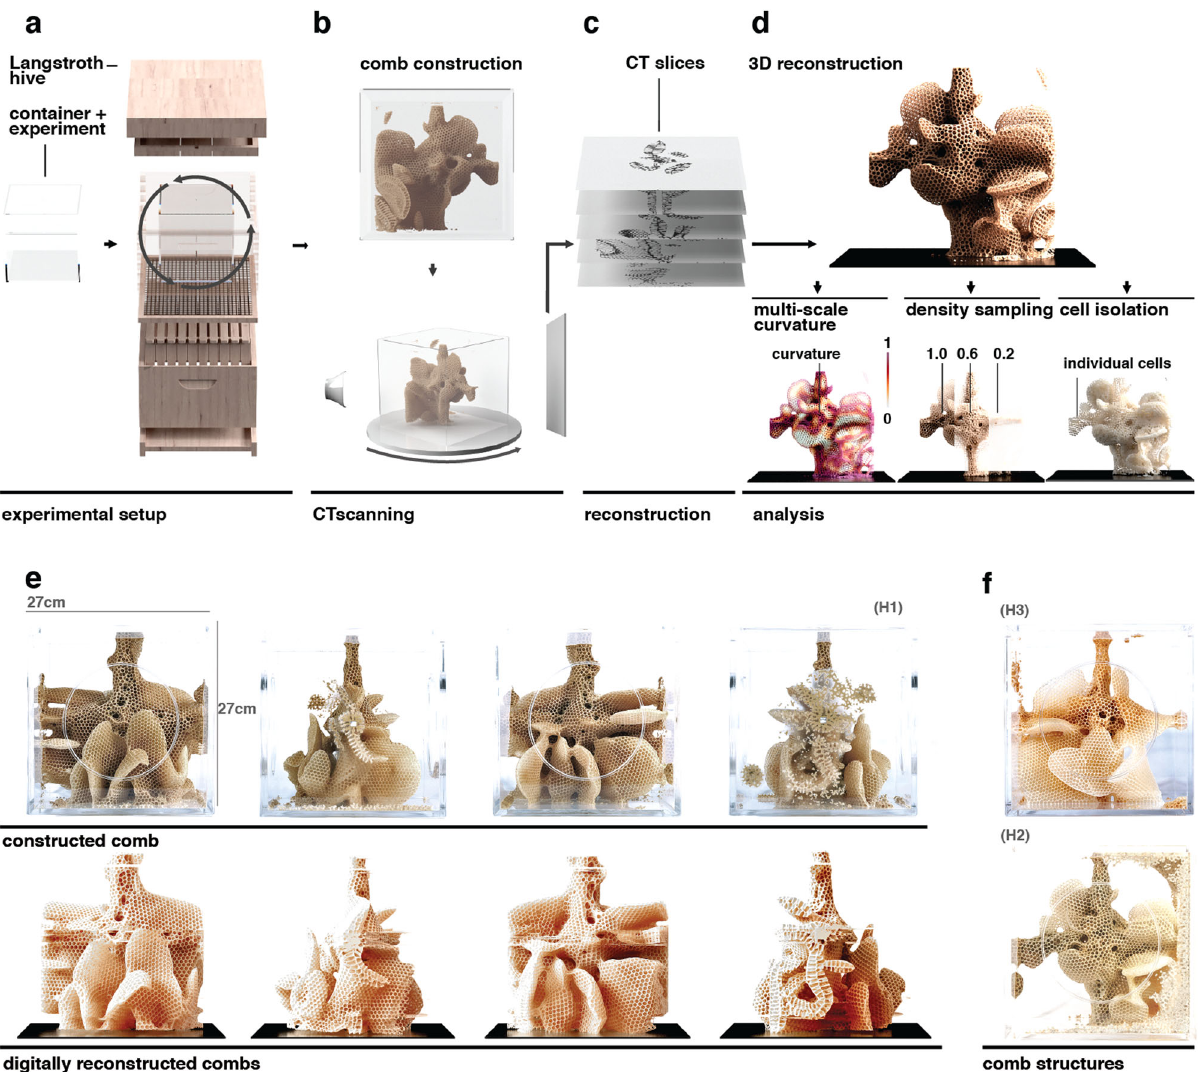
Fig. 2 Hive experimental setup and data digitization work fl ow. a In our experimental approach, combs were constructed by A. mellifera colonies inside experimental acrylic cubes that were integrated into standard Langstroth hives. Periodic rotations applied to the acrylic cubes during hive construction induced changes in the hive ’ s build direction, resulting in combs with atypical protrusions and highly curved geometries. b After the comb construction process was complete, the acrylic cubes were removed from the hives and scanned using a commercial micro-CT imaging system. c For each cube, 2000 16-bit z slices at a resolution of 2000× 2000 pixels were generated. d The slices were reassembled into a volumetric data set and stored as OpenVDB fi les for further analysis. e Photographs (upper) and digital reconstructions (lower) produced by the described work fl ow are shown for Hive 1. f Photographs showing two additional replicate experimental cubes (Hive 2 and Hive 3) produced and digitized with this work fl